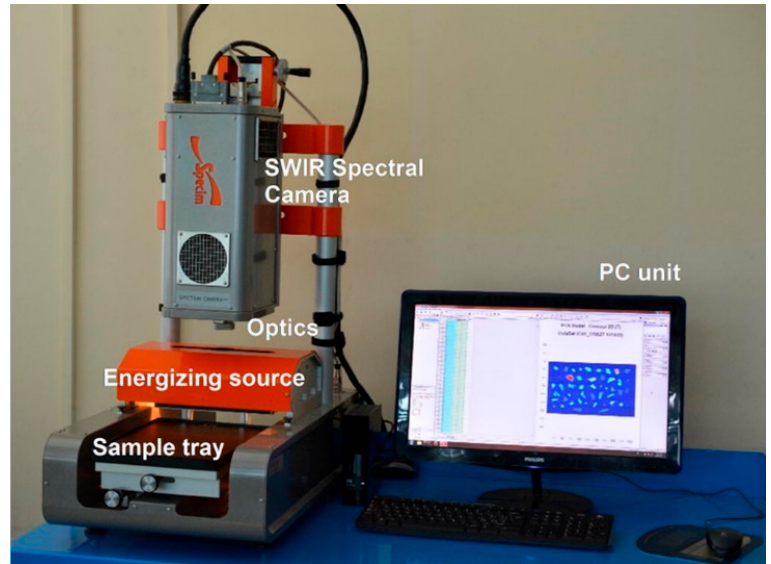
Figure 6. An overview of SISUChema XL™ Chemical Workstation (Specim, Finland) [104]. Reprinted from Waste Management , 76, Serranti, S.; Palmieri, R.; Bonifazi, G.; Cózar, A. Charac-terization of Microplastic Litter from Oceans by an Innovative Approach Based on Hyperspectral